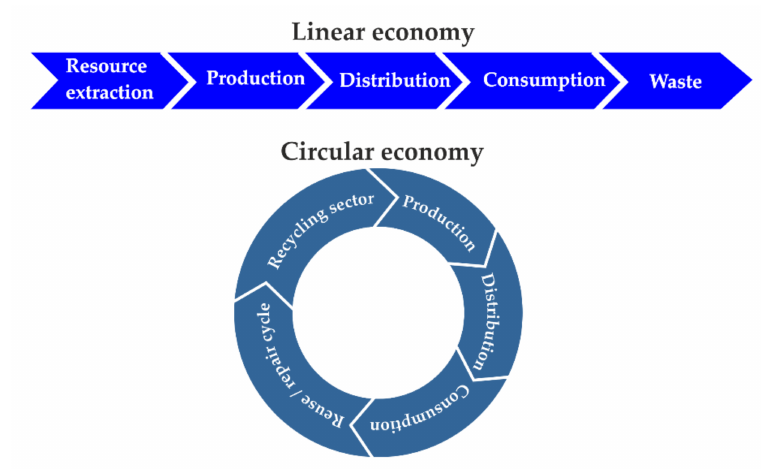
Figure 1. Linear vs. circular